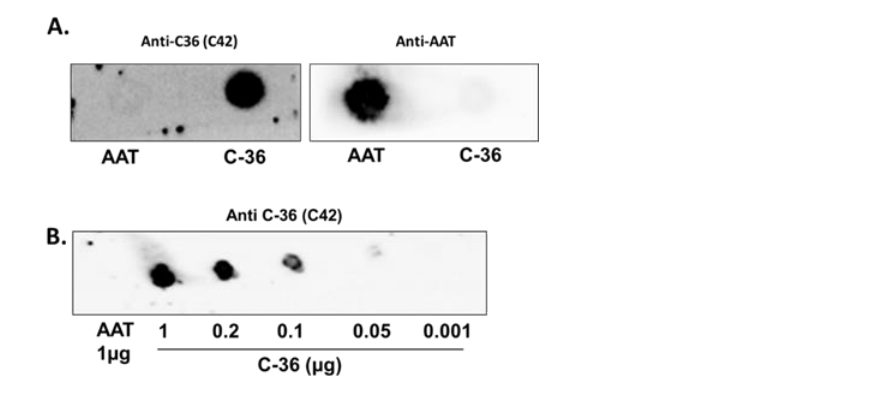
Figure 1. The specificity of the purified antibody (C42 mAb) tested by dot-blot analysis. ( A ). Full-length plasma purified alpha1-antitrypsin (AAT) (1µg) and C-36 peptide (1µg) or ( B ) various amounts of C-36 peptide were blotted onto the nitrocellulose membrane and the dot-blotted membranes were incubated with a mouse C42 mAb (1:500). In (A), the same blot we developed again with mouse monoclonal anti-human AAT antibody (1:1000). The immune complexes were visualized with horseradish peroxidase-conjugated secondary anti-mouse antibody (1:10 000) and enhanced by ECL substrate. Images created using Chemidoc Touch imaging system. Representative dot-blots show that ( A ) C42 mAb reacts with C-36 peptide of AAT but not with AAT protein and ( B ) C42 mAb recognizes C-36 peptide in a concentration dependent manner.